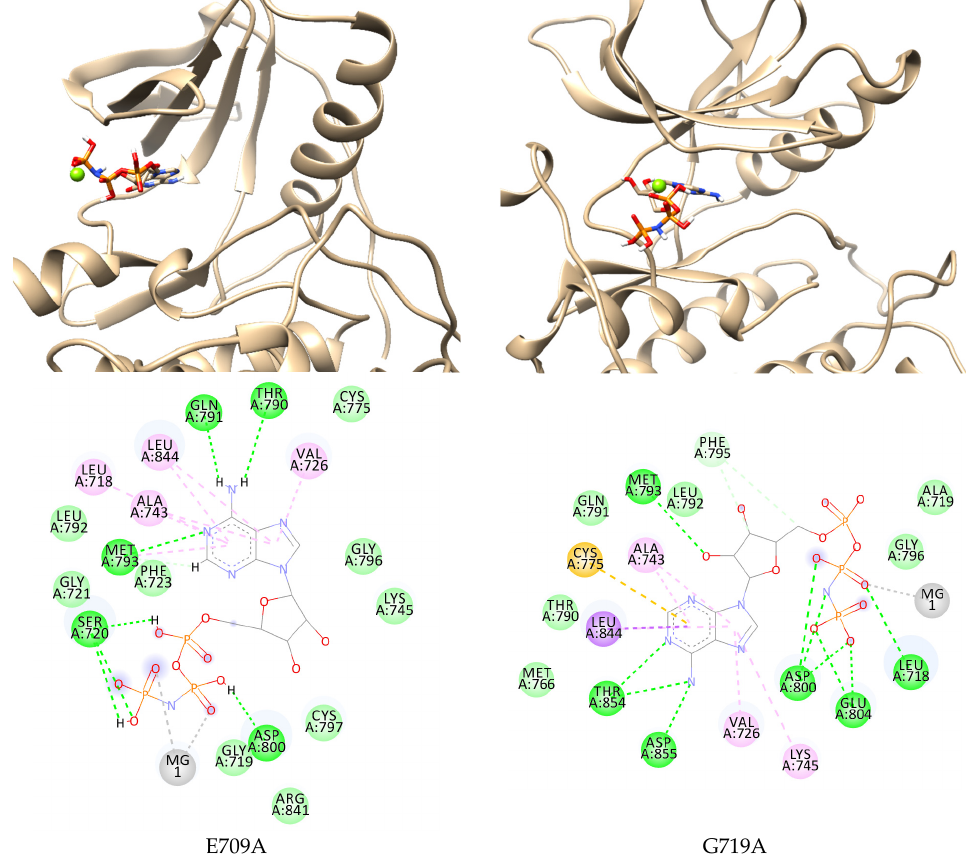
Figure 3. Two- and three-dimensional interaction of ANP in E709A and G719A EGFR. Interactions are colored based on the type: , hydrogen bond; , van der Waals; , metal acceptor; , pi-sigma; , pi-sulfur; , pi-alkyl.